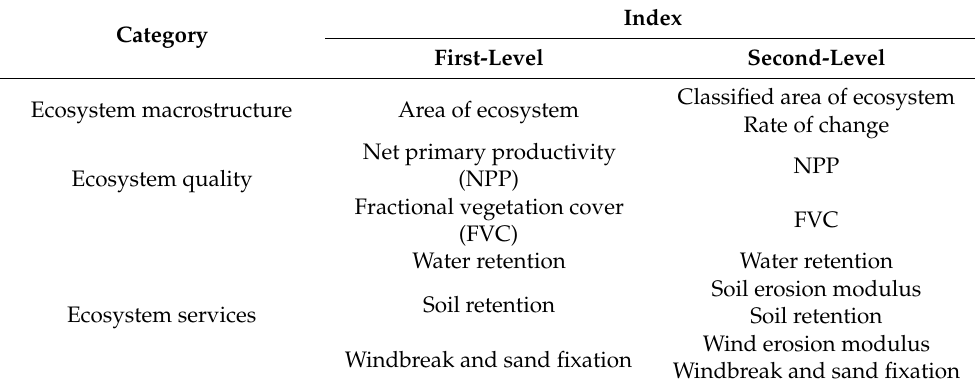
Table 1. Indices used to assess the ecological restoration Table 1. Indexes used to assess the ecological restoration degree. 198